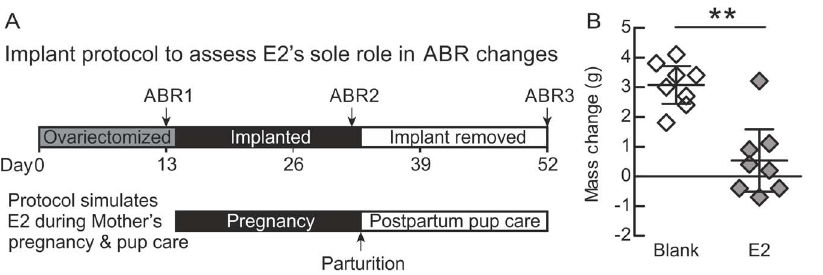
Figure 5. Time course and efficacy of hormone manipulation. A) Timeline of estradiol treatment and auditory brainstem response recordings in relation to the mouse pregnancy and maternal care timeline. B) Change in mass from the beginning of estradiol treatment to the end verifies the expected reduced weight-gain from elevated estradiol levels. Middle bars represent the means; error bars represent 95% confidence intervals. doi:10.1371/journal.pone.0101630.g005 PLOS ONE |